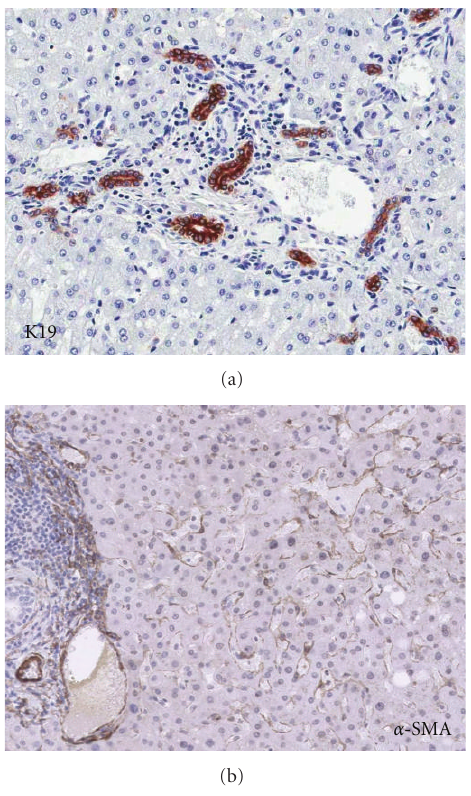
Figure 4: Ductular reaction and activated myofibroblasts in the nontumorous liver. (a) Ductular reaction in a portal tract of a distant nontumorous liver sample highlighted by K19 immunos- taining. (b) Presence of α -SMA-positive myofibroblasts in a distant nontumorous liver sample, most obvious in dilated